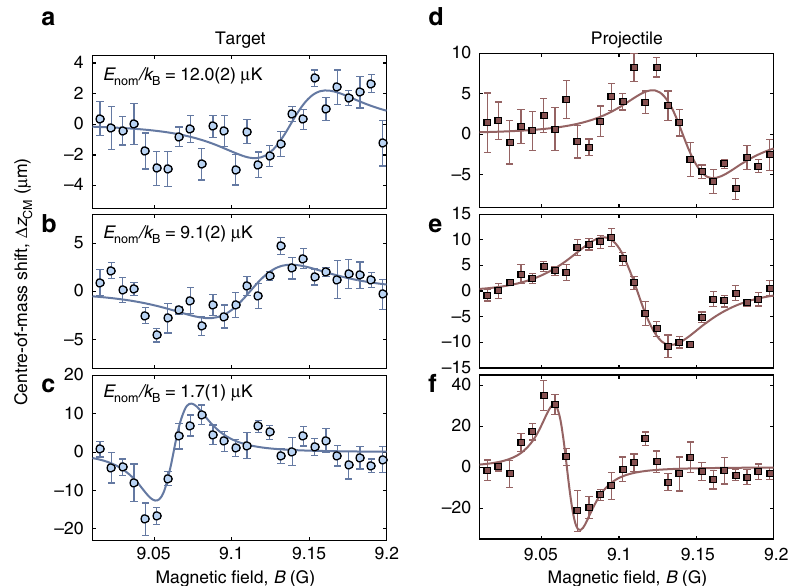
Fig. 5 Center-of-mass shifts for clouds colliding at a Feshbach resonance. Measured shifts in the center-of-mass Δ z CM ( B ) at nominal relative collision energies E nom / k B = 12.0(2) μ K, 9.1(2) μ K, and 1.7(1) μ K for the target cloud ( a – c , blue circles ) and the projectile cloud ( d – f , red squares ) as a function of B . Data points are the mean of fi ve repeats, with the error bars corresponding to the standard error. Solid lines show pseudo-Voigt fi ts to the data (see “ Methods ” )